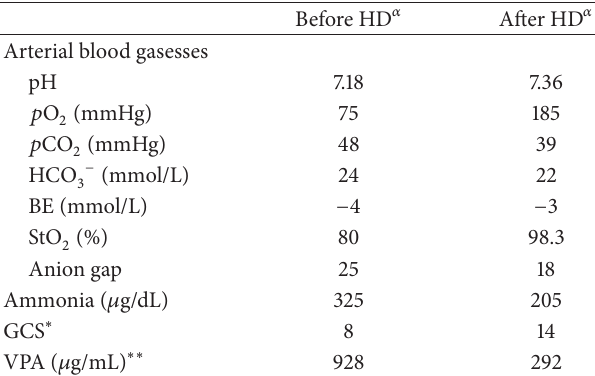
Table 1: Arterial blood gasesses, GCS, and VPA values before and after HD.